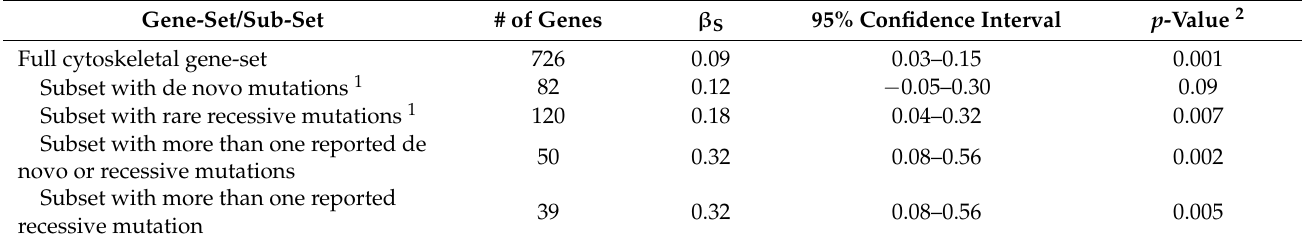
Table 4. Summary of post hoc analyses of the association between CTDs and the cytoskeletal gene-set and sub-sets.